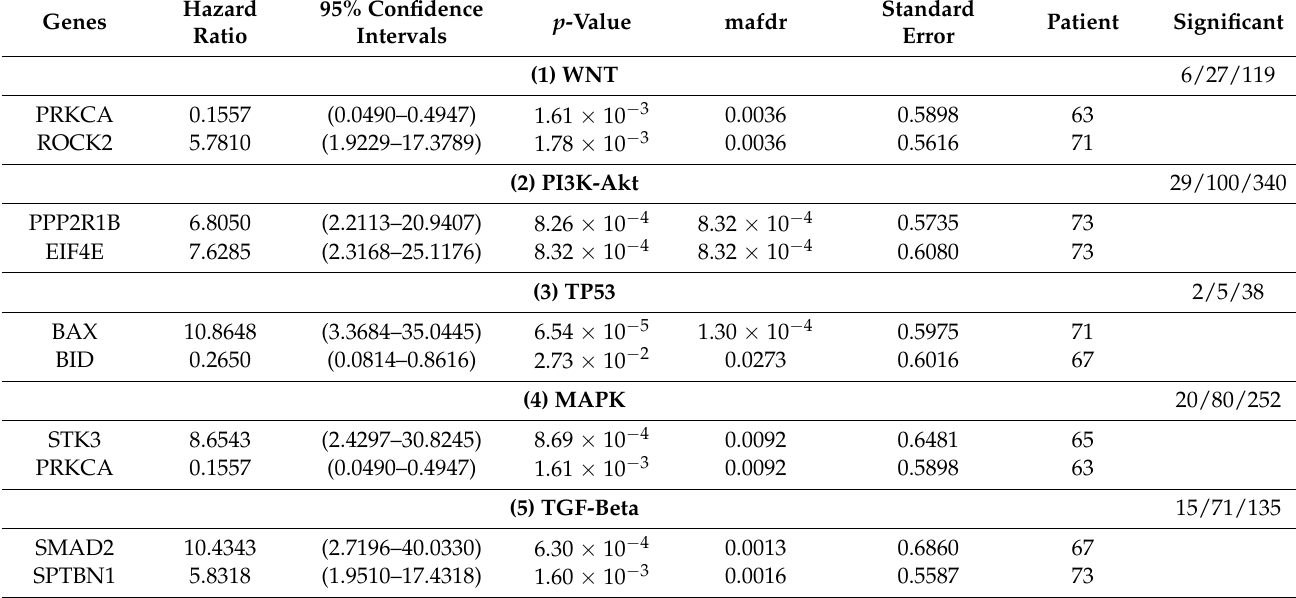
Table 3. The top two significant proteins across five CRC relevant signalling pathways from the TCGA Legacy dataset. A Kaplan–Meier estimate and log-rank test were used to compute the Pearson correlation between patient event-free survival and protein expressions. The associated hazard ratio, 95% confidence interval, p -value, mafdr (estimate positive false discovery rate for multiple hypothesis testing), and standard error are apparent. “Patient” indicates the number of patients the corresponding protein was determined in. The last column, “significant”, in the format X/Y/Z lists the number of significant proteins in each STN (X), the number of genes within the pathway with available protein information (Y), and the total number of genes in the pathway